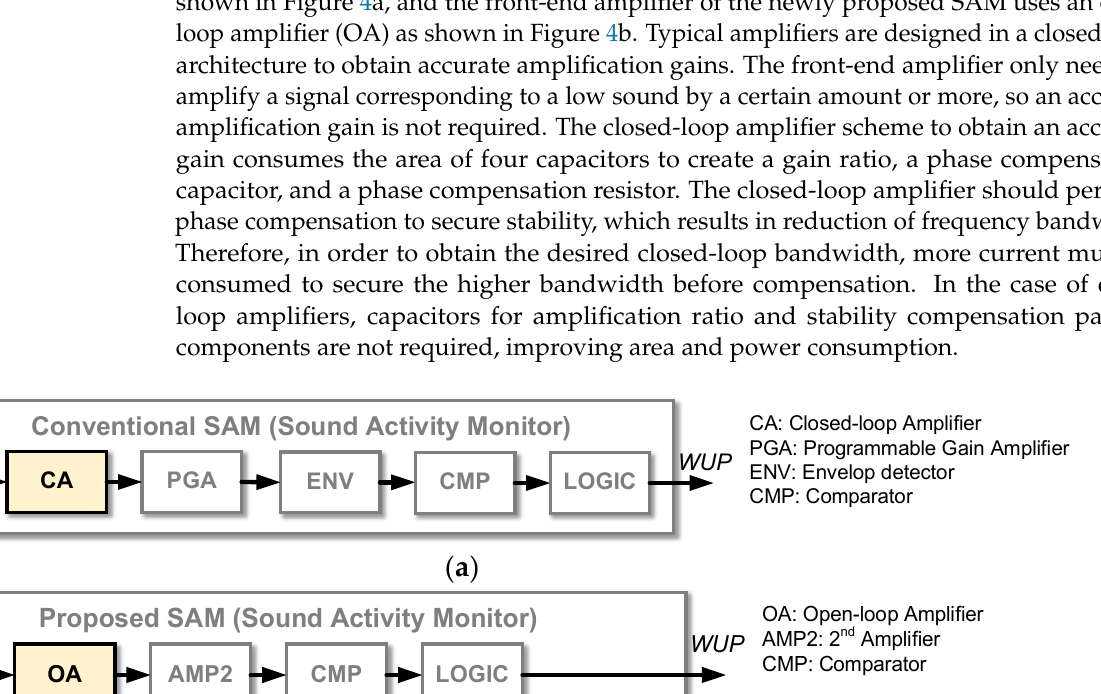
Figure 3. Architecture approach 1: ( a ) Configuration when SF and SAM share MEMS input terminal; ( b ) Configuration when MEMS input connects only to SF.